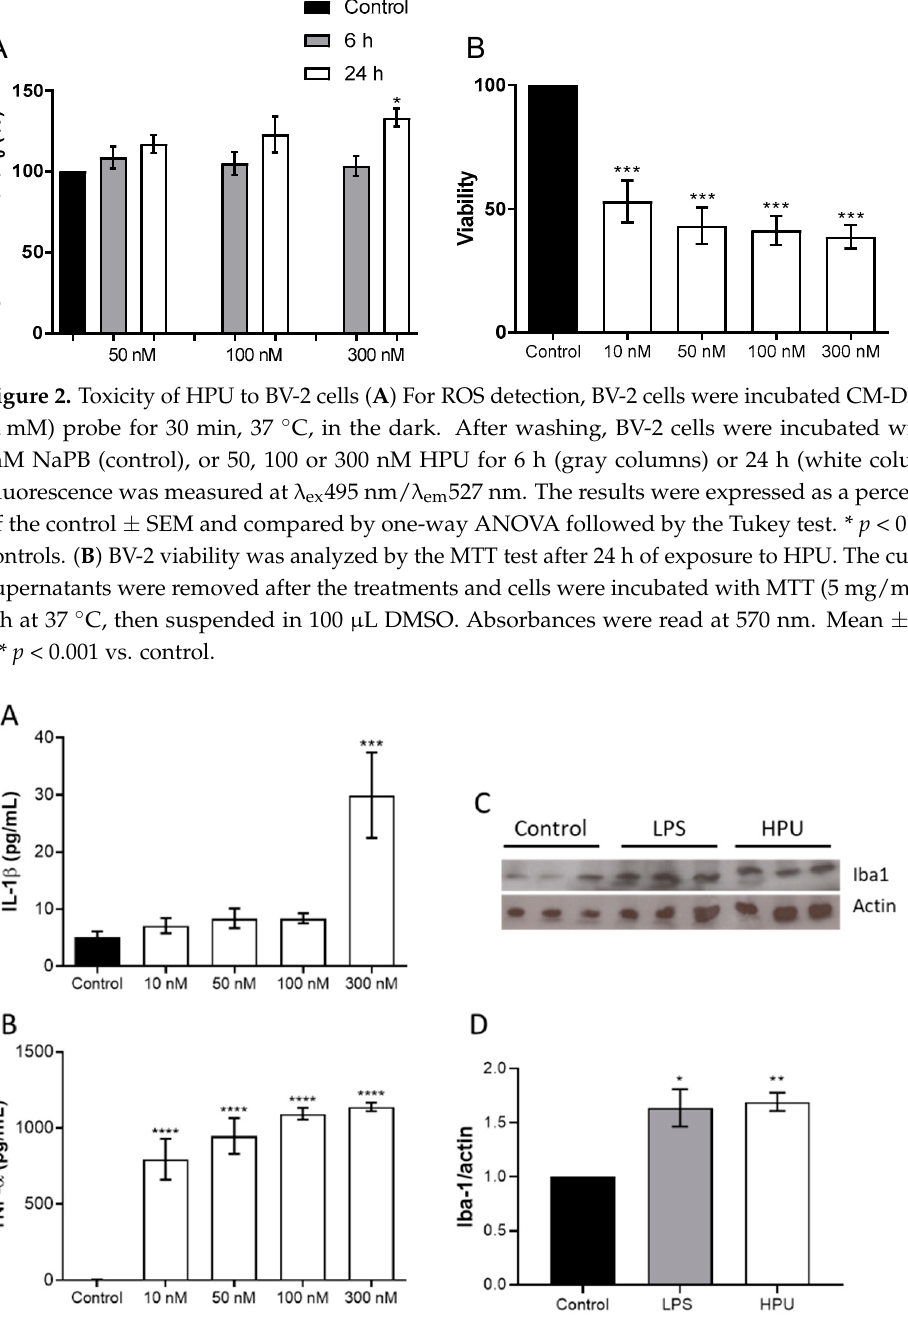
Figure 3. Microglial activation by HPU. For detection of cytokine expression, BV-2 cells were incubated for 6 h with HPU, and cultures’ supernatants were collected for detection of IL-1 β panel ( A ) and TNF- α panel ( B ) by ELISA. The data (mean ± SEM) were analyzed by one-way parametric ANOVA with a Dunnett post-test. *** p < 0.001, **** p < 0.0001 vs. control. Panels ( C , D ): Iba1 levels in brain homogenates of HPU-treated rats were analyzed by Western blots ( C ), and quantified by densitometry ( D ). The data (mean ± SEM) were analyzed by one-way ANOVA followed by Bonferroni post hoc test. * p < 0.05, ** p < 0.01 vs. controls. All data were normalized against the endogenous actin content.